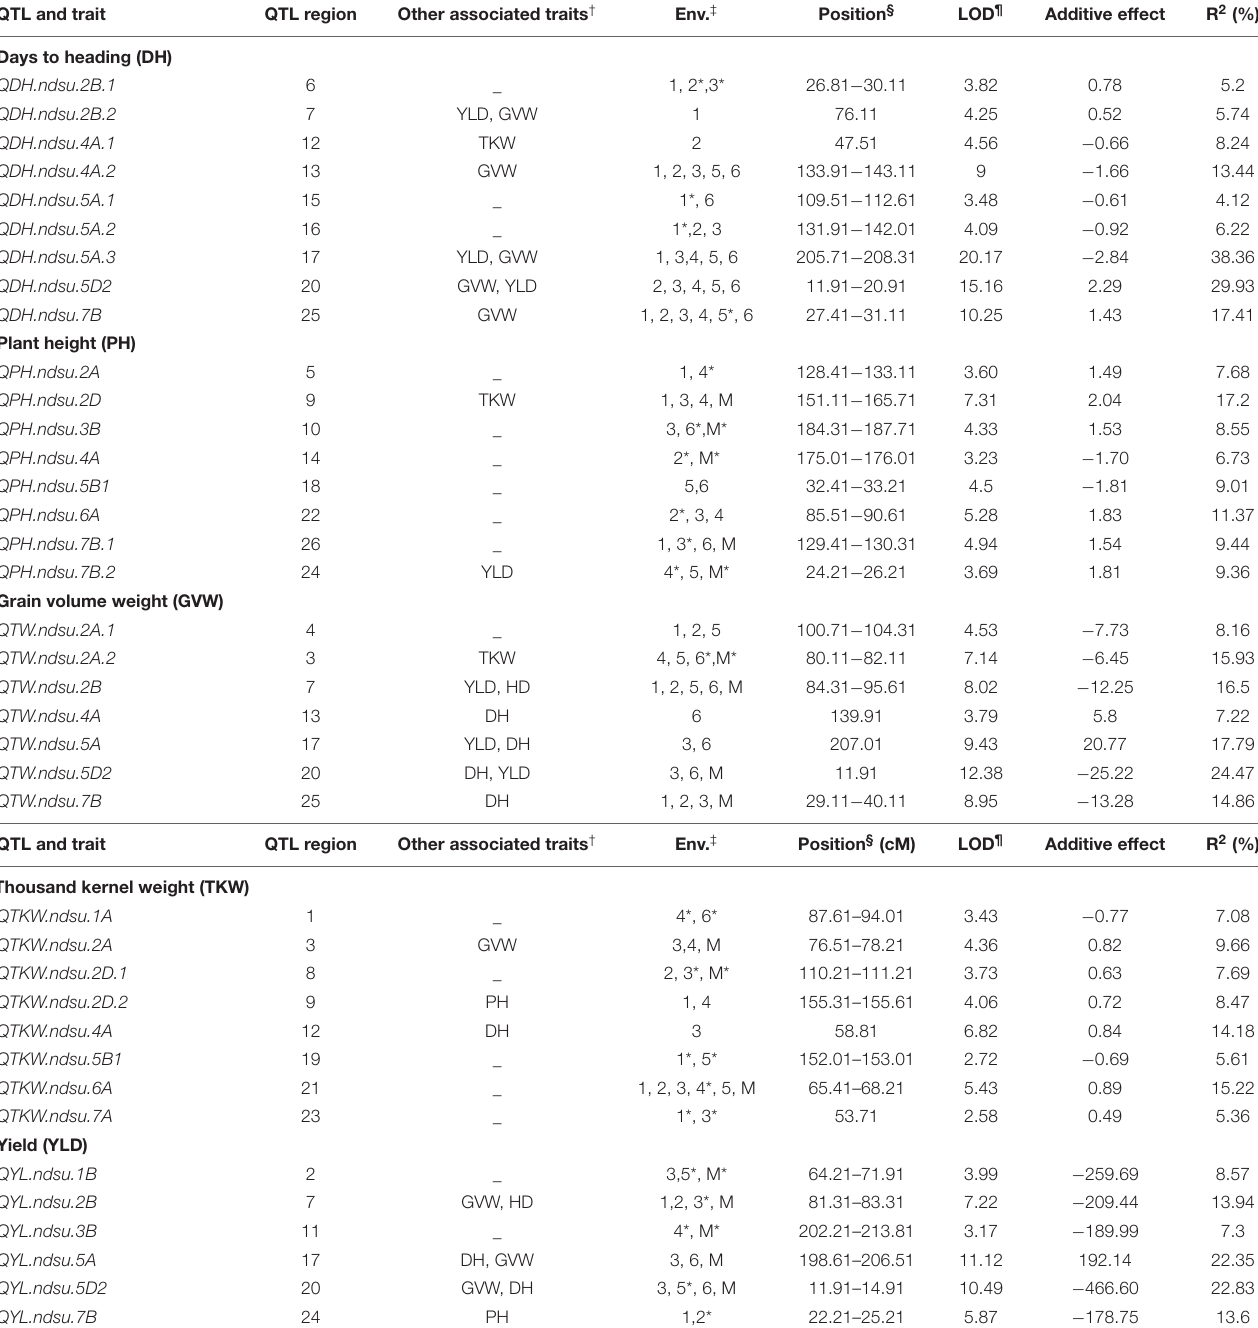
TABLE 5 | Quantitative trait loci identified for the agronomic traits in an RIL population derived from the cross between Reeder and Albany. QTL and trait QTL region Other associated traits † Env. ‡ Position § LOD ¶ Additive effect R 2